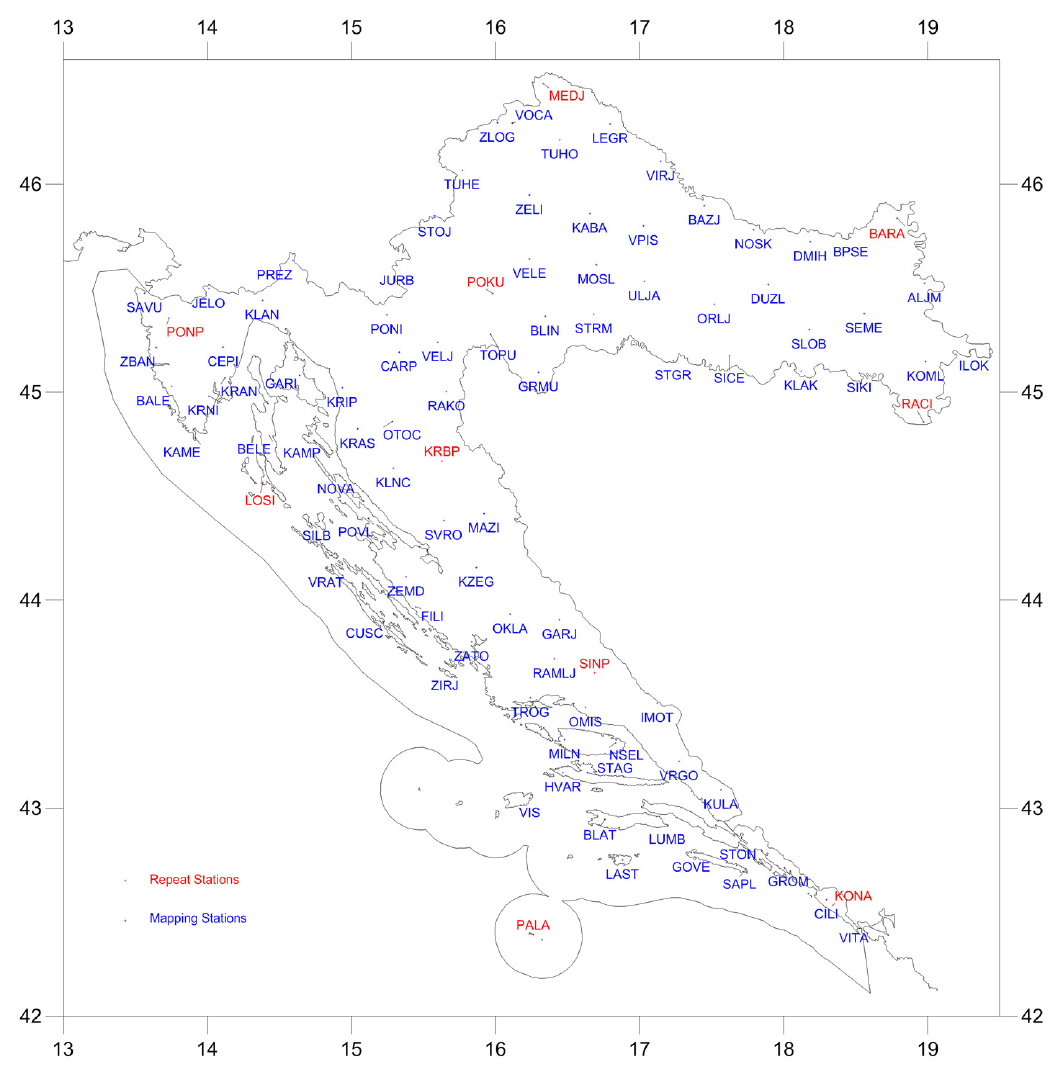
Figure 1. The Croatian Basic Geomagnetic Network. The network consists of 10 locations of CGRSN and 88 locations of CGNFM today. The network density was roughly 1 location per 663 km 2 which corresponds to the current average distance between the locations of 26 km.